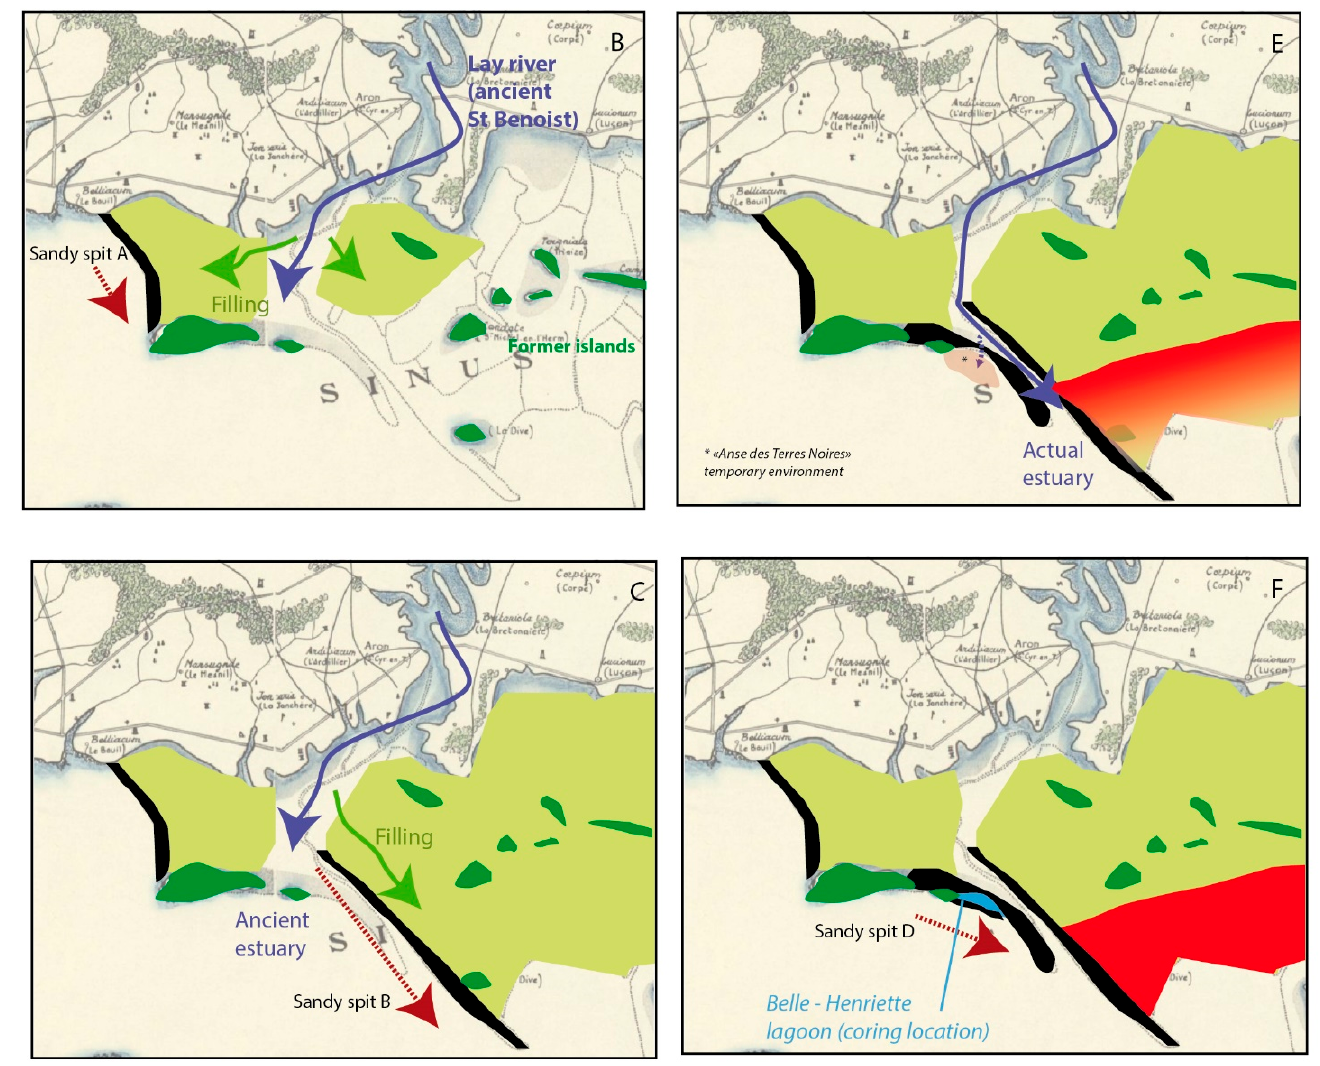
Figure 2. Summary of the paleoenvironmental evolution of the Belle Henriette lagoon. ( A ) Ancient “Golfe des Pictons” maritime bay (marine transgression linked to the Holocene interglacial period); ( B ) starting of the infilling of the western Marais Poitevin from the sandy spit A progradation and the alluvial deposits transported by the Lay (former St. Benoist) River (estimated post-540– 230 BC); ( C ) filling of the eastern part of the site due to the progradation of the sandy spit B and the continuous filling of alluvial deposits (estimated between the end of Antiquity and the Early Middle Ages); ( D ) start of the sandy spit C progradation (estimated since AD 750) and presentation of the polderization of the western Marais Poitevin since the 18th century; ( E ) the “Anse des Terres Noires” temporary silty environment established during the progradation of sandy spit C that has been breached near the Lay estuary (estimated near AD 1820); and ( F ) implementation of the BelleHenriette current lagoonal environment with the progradation of sandy spit D (estimated at the early 20th century). The map used as a background is named “Carte arch é ologique du Bas-Poitou” from the Regional Archives of Vend é